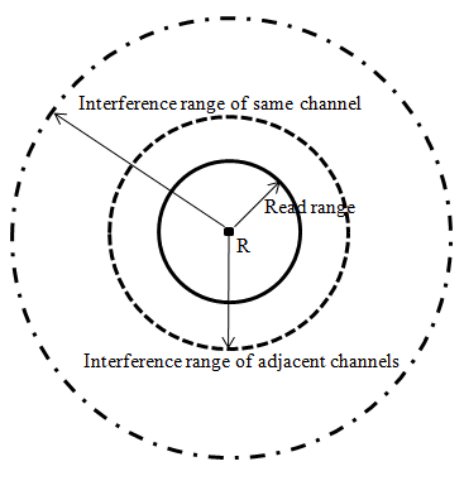
Figure 4. Interference ranges of a reader.